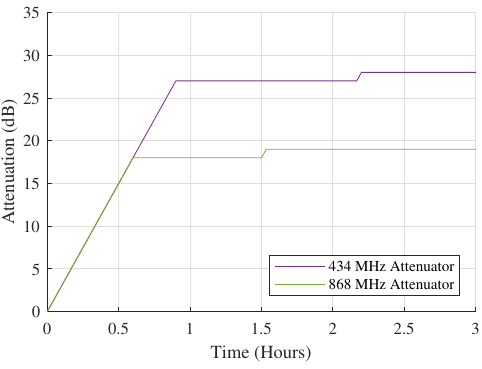
Figure 11. Attenuator startup behavior at outdoor receiver RX2. The slow response is a result of legal restrictions, but also prevents the system from reacting to sudden, temporary